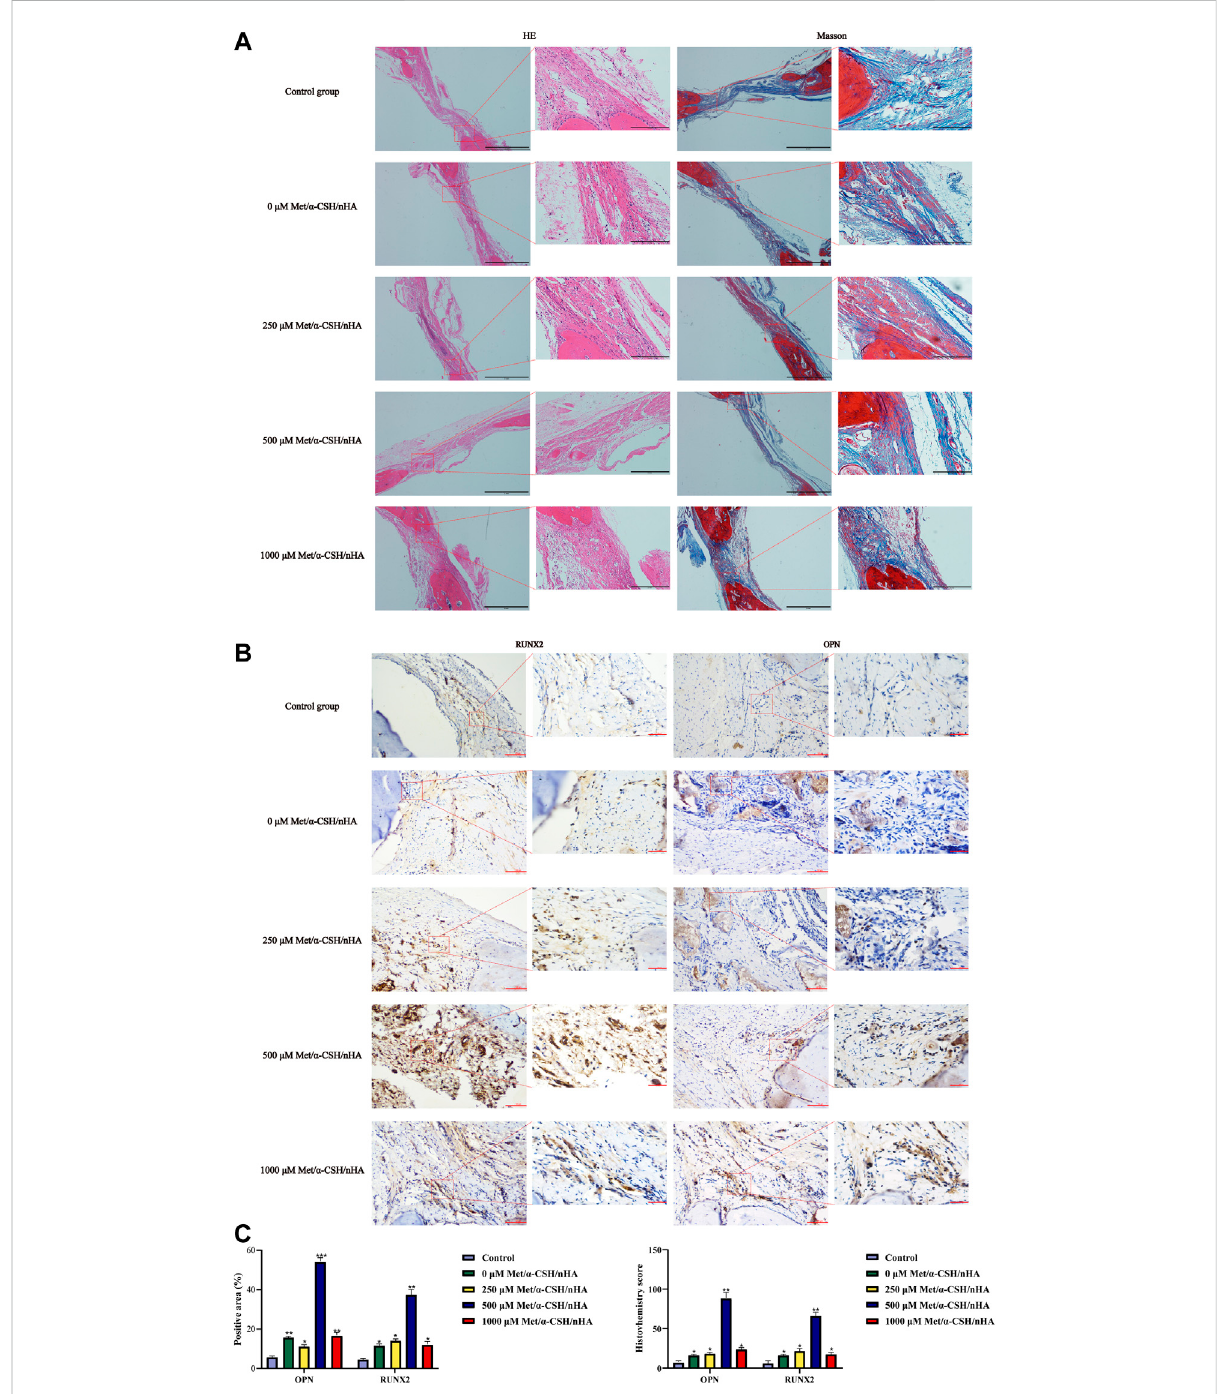
FIGURE 5 Met/ α -CSH/nHA with different drug concentrations (0, 250, 500, and 1,000 µM) for enhancing osteogenic properties. The results of HE and Masson staining are shown in (A) (Scale bar = 2 mm). The expression of theosteogenesis-related genes RUNX2 and OPN is shown in (B) (Scale bar = 100 μ m). The quantitative histochemical analysis (C) was based the positive area and